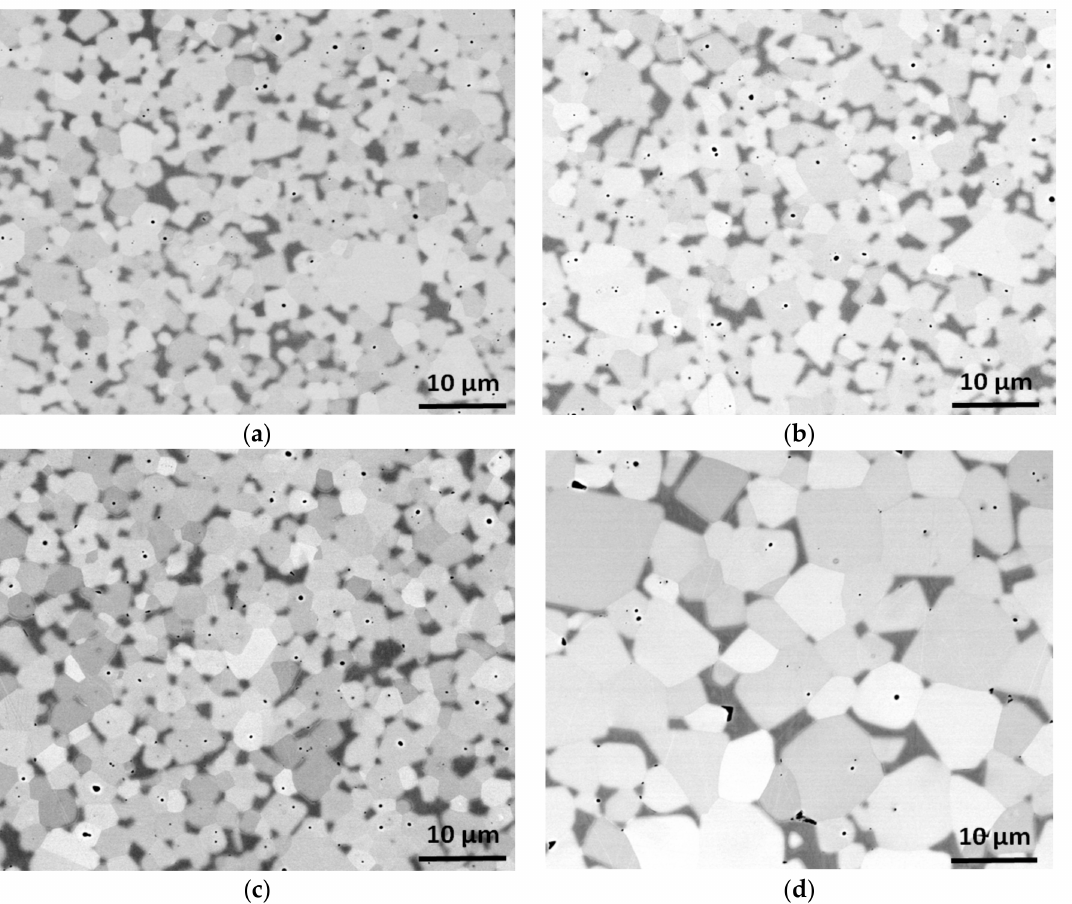
Figure 5. Influence of carbon content on the microstructure of 5 vol % VC modified NbC-12 vol % Ni cermet sintered for 1 h at 1420 ◦ C. ( a ) (NbC-4NbH 2 )-5VC-12Ni, ( b ) (NbC-2NbH 2 )-5VC-12Ni, ( c ) NbC-5VC-12Ni, ( d ) (NbC-2C)-5VC-12Ni (vol %). The phase analysis from XRD patterns indicated all sintered cermets are composed of a fcc solid solution Ni binder and cubic solid solution (Nb,V)C phase, as shown in Figure 6a. The lattice parameter of the cubic (Nb,V)C and Ni binder in the 12 vol % Ni bonded cermets are plotted in Figure 6b. Compared to the NbC starting powder and NbC-12Ni cermets, the dissolution of VC into the NbC phase resulted in a clearly decreased unit-cell since the atomic radius of V is smaller than that of Nb. The dissolution of V in NbC grains was also confirmed by energy dispersive spectrometer (EDS) analysis. The concentration of V in NbC grains is increased with increasing C content, from 2.75 wt % V in the (NbC-4NbH 2 )-5VC-12Ni (vol %) cermet to 3.69 wt % V in the (NbC-2C)-5VC-12Ni (vol %) cermet. The influence of the C content on the lattice parameters of NbC and Ni phases are similar as for the NbC-Ni cermets (Figure 3). With increasing carbon addition, the lattice parameter of (Nb,V)C gradually increased, whereas the lattice parameter of the Ni binder decreased indicating that the dissolution of V and Nb in the Ni binder decreased with increasing carbon